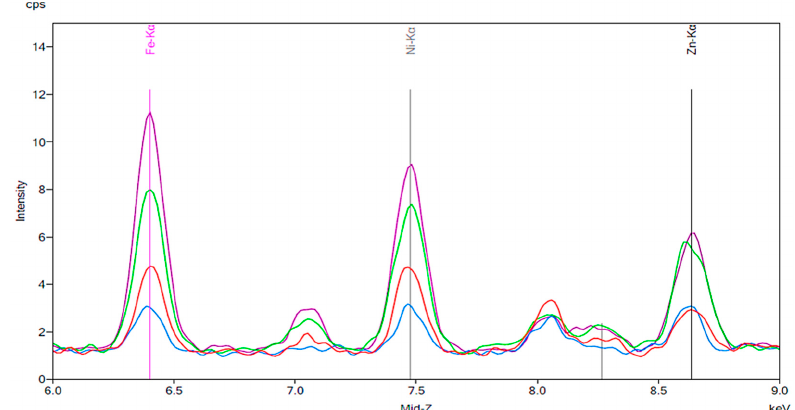
Figure 6. The results of an experiment in which new artificial resin teeth were exposed to cola for 24 h. The red peaks represent the new artificial tooth prior to exposure to cola. The green peaks indicate the same artificial tooth following exposure to cola for 24 h.